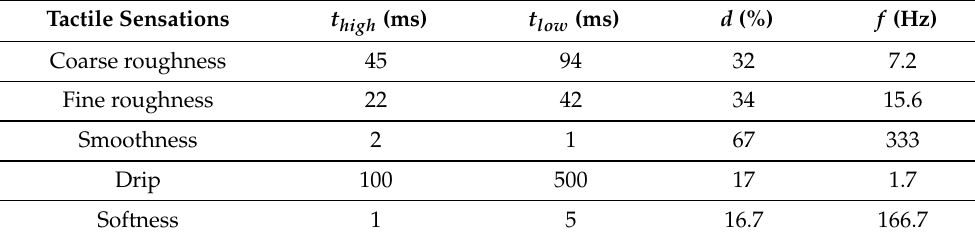
Table 1. Modeled tactile sensations.